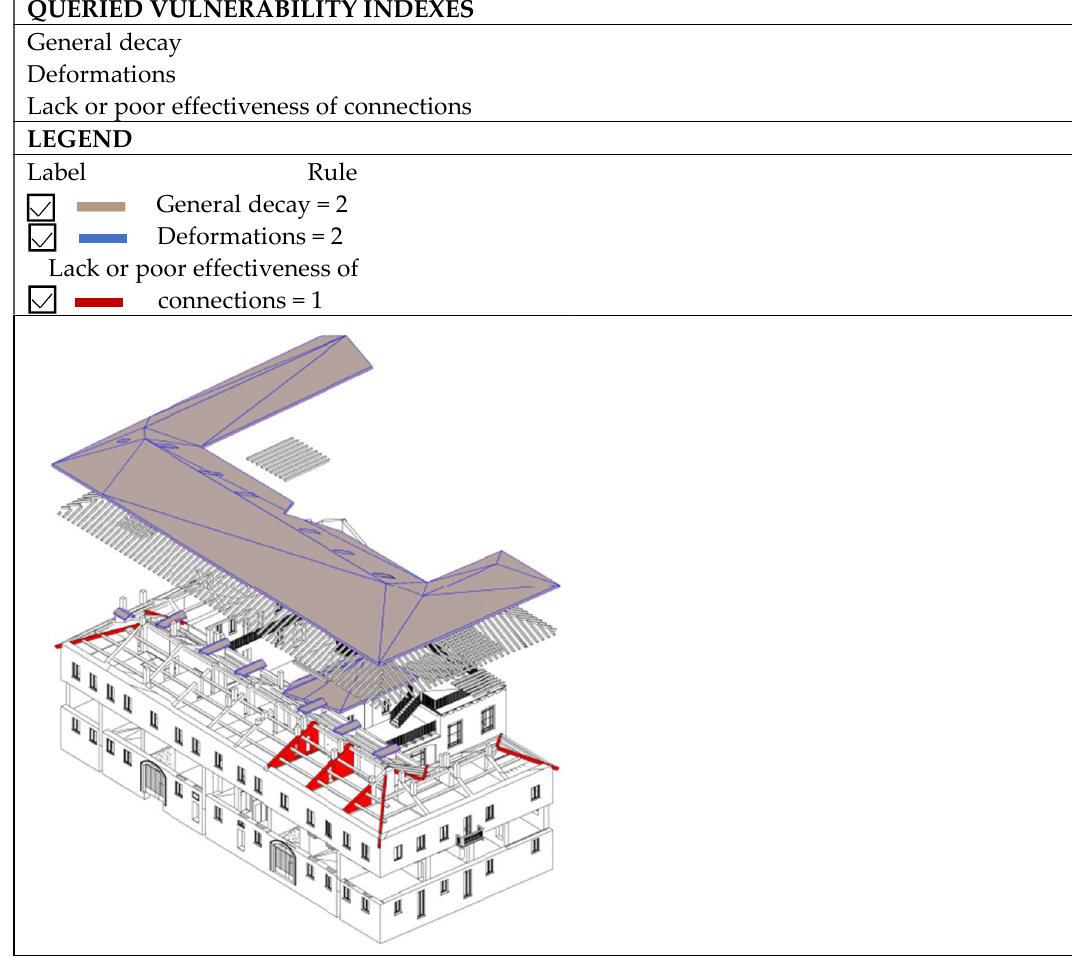
Figure 11. Integrated queries: display of three different types of specific vulnerabilities with an impact of less than 2 on the overall vulnerability.